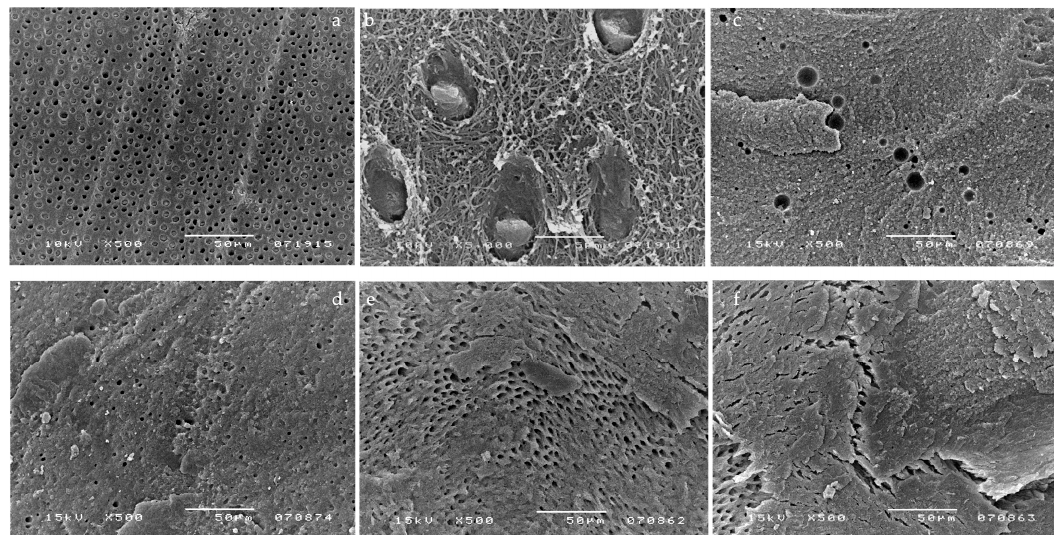
Figure 5. SEM photomicrographs illustrating fractured surfaces for samples bonded with Bond Force. ( a , b ) Micrographs show the morphology of Bond Force when applied without pulpal pressure (0 cm H 2 O) (mixed fracture). Several droplets and the delamination of the bonding layer were observed. ( c , d ) Micrographs show a representative sample of Bond Force applied during the application of pulpal pressure (mixed fracture). Almost the entire adhesive layer was affected by droplets and voids from 5 to 10 μ m. ( e , f ) shows a representative sample of Bond Force applied and cured before the application of pulpal pressure (mixed fracture).